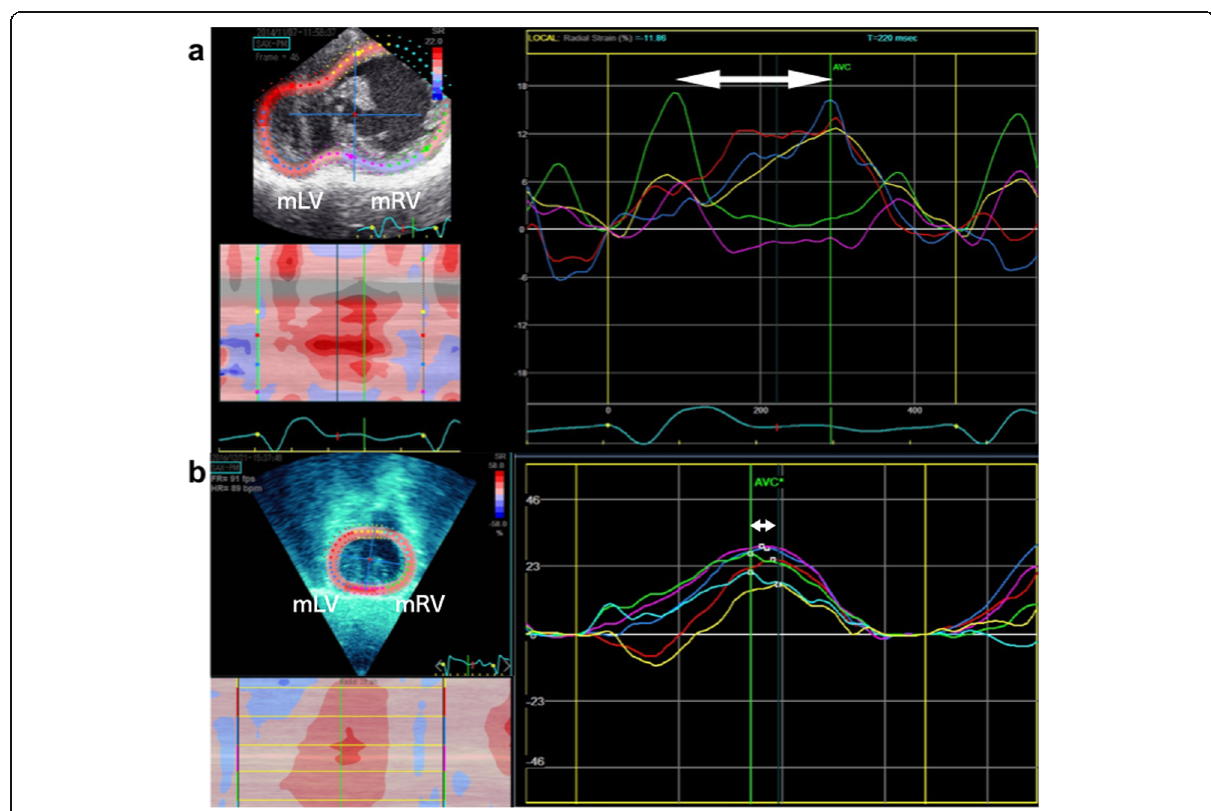
Fig. 2 a Speckle tracking echocardiography reveals that the difference in time to peak radial strain between both ventricles is 210 ms before CRT (white arrow). b Speckle tracking echocardiography after CRT shows good interventricular synchrony between both ventricles. The peak radial strain between both ventricles is very short (white arrow). CRT, cardiac resynchronization therapy; mLV, morphological left ventricle; mRV, morphological right